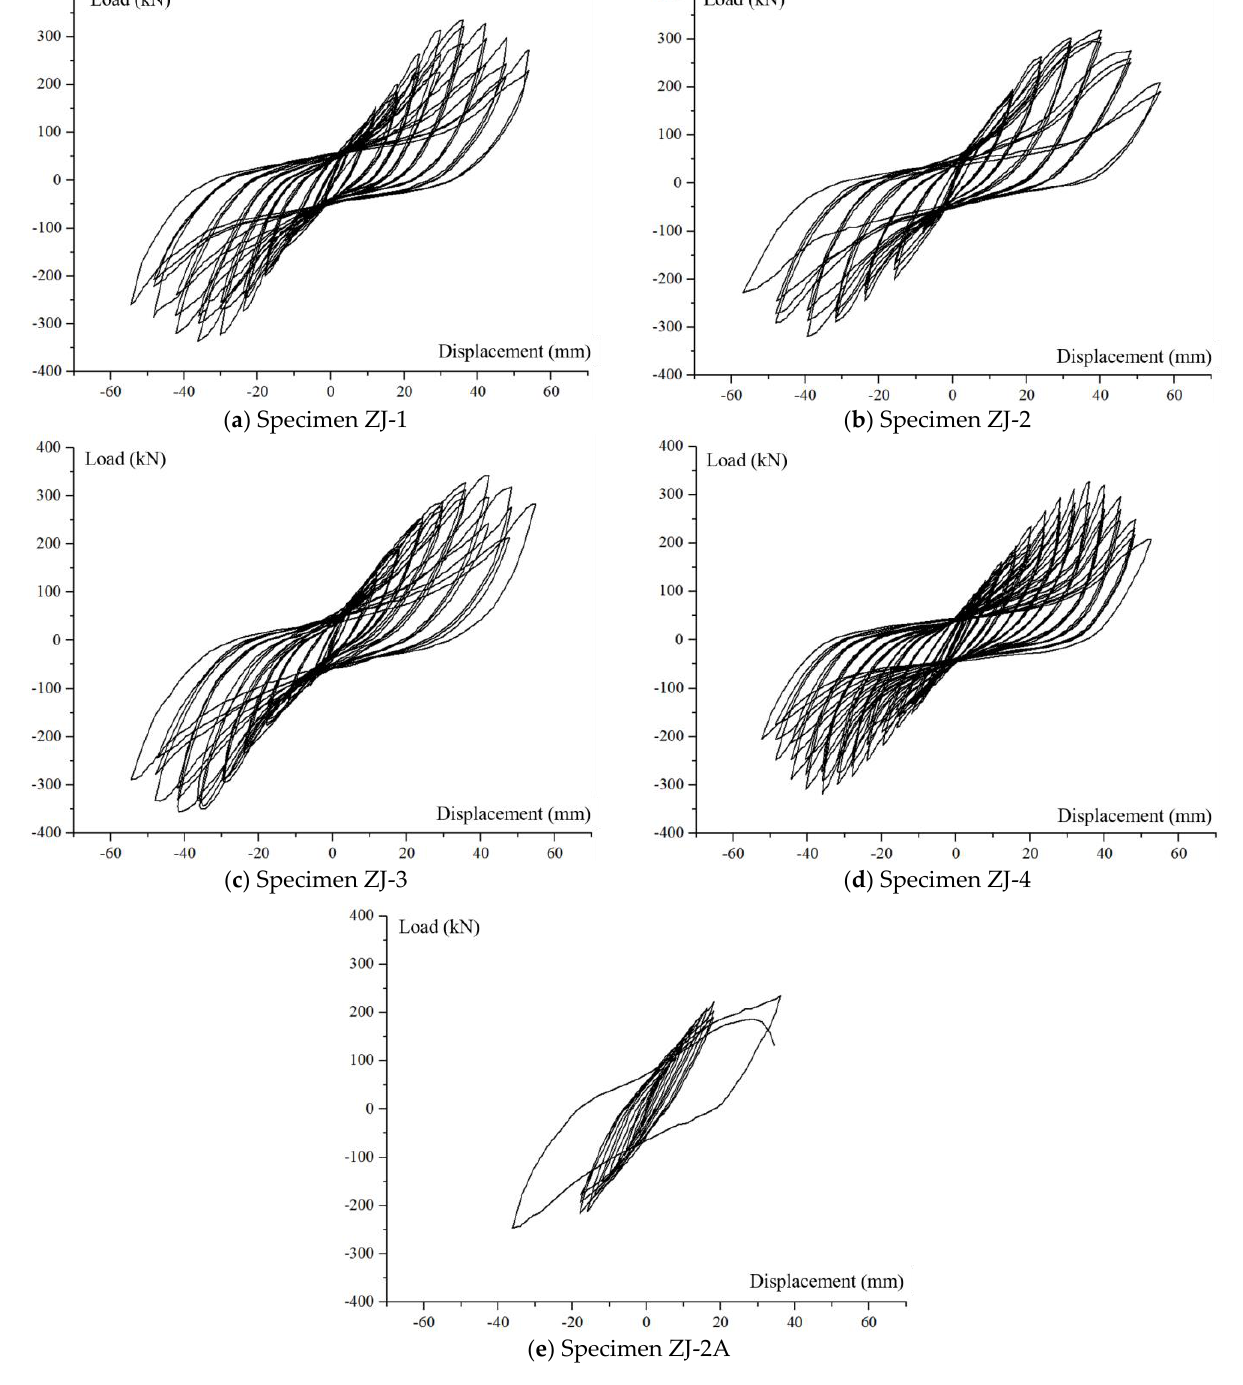
Figure 18. Hysteretic curves of cruciform joints.